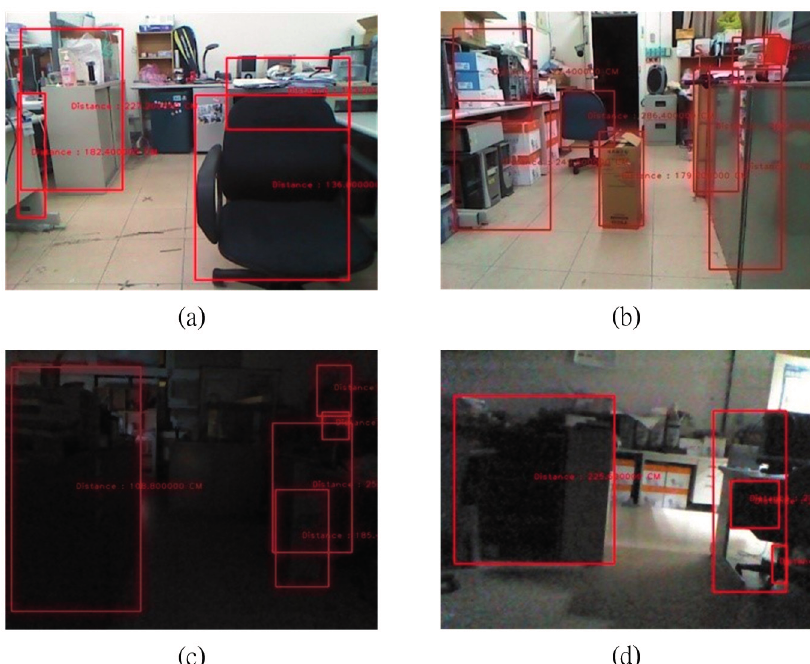
Figure 17. The results for obstacle detection. ( a ) Bright indoor; ( b ) Bright indoor; ( c ) Low-light indoor; ( d ) Low-light